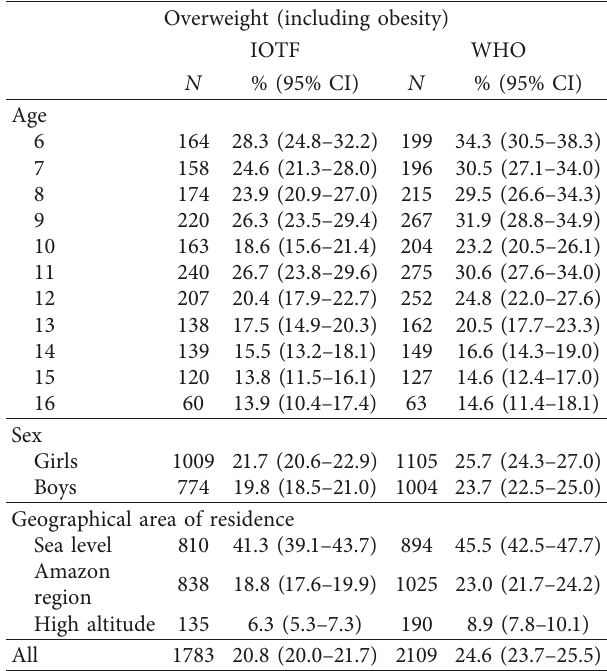
Table 3: Prevalence of overweight (including obesity) ( n % and 95% confidence intervals), based on IOTF and WHO cutoff points, by age, sex, and geographical area of residence. Overweight (including